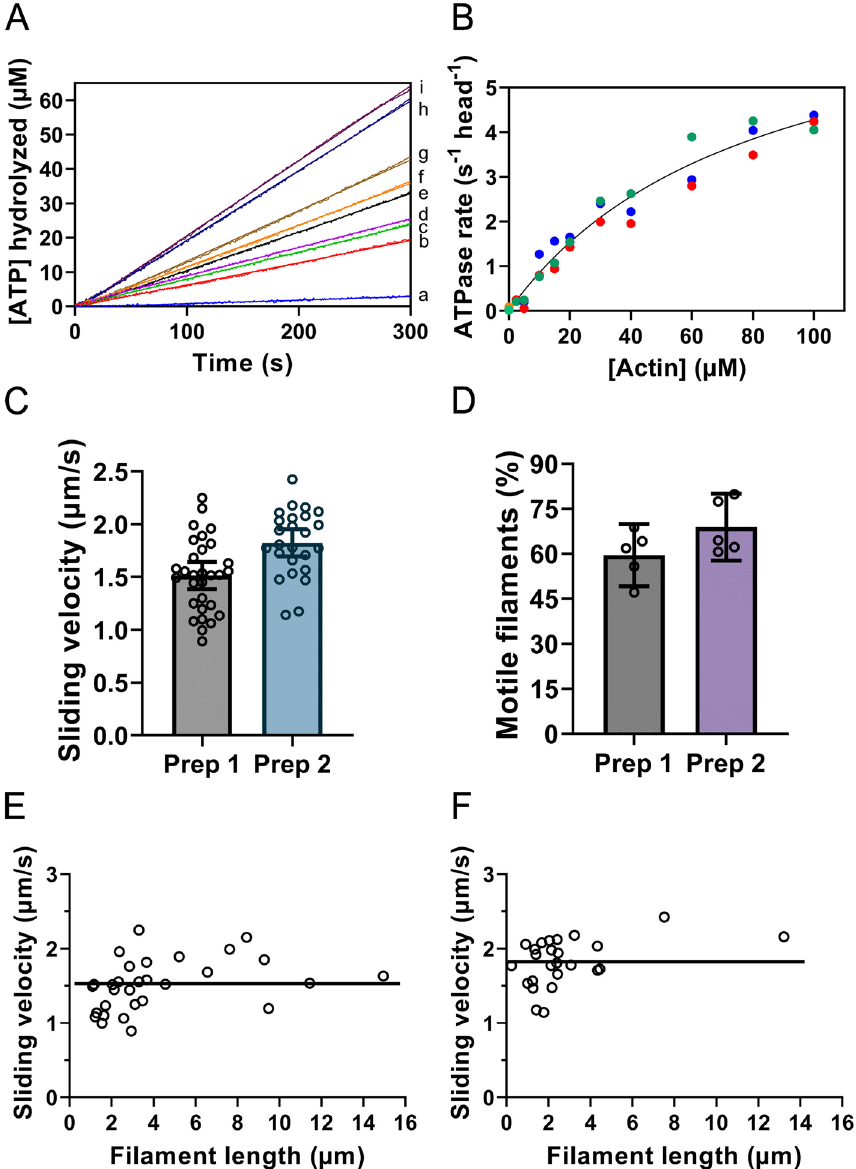
Figure 3. Functional assays of purified human β-cardiac S1L construct co-purified with murine myosin light chains. ( A ) time courses of ATP turnover, using NADH-coupled assay, with constant [S1L-eGFP-FLAG] and [MgATP] but with [F-actin] (concentration relating to monomers) at either 5 (a), 10 (b), 15 (c), 20 (d), 30 (e), 40 (f), 60 (g), 80 (h), or 100 (i). ( B ) Actin-activated steady-state ATPase activity as a function of [F-actin]. The solid line through the data points is the best fit of Eq. (1) to the data with best-fit parameters presented in Table 1. Data from three independent protein preparations shown in different colors. ( C ) The sliding velocities of actin filaments in the in-vitro motility assay at 25 °C for two different protein preparations (Prep 1 and Prep 2). The data are superimposed on mean ± 95% CI from 25–30 filaments for each preparation. ( D ). The fraction of motile filaments after one (for Prep 1) or two (for Prep 2) affinity purifications (“deadheadings”). The data are superimposed on mean ± 95% CI from 5 fields of view per flow cell for each preparation. ( E ) Actin filament sliding velocities versus filament lengths (same data as in C for Prep 1). ( F ) Actin filament sliding velocities versus filament lengths (same data as in C for Prep 2). Straight horizontal lines in E and F indicate mean values suggesting minimal dependence of velocity on filament lengths at lengths > 3